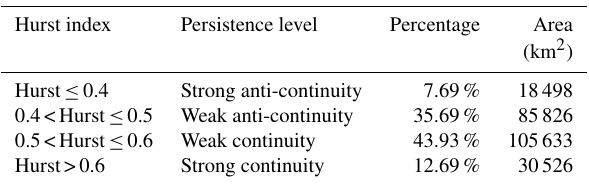
Figure 4. Monthly variation of NDVI in the Yarlung Zangbo River Basin. Table 1. Persistence of monthly NDVI in the Yarlung Zangbo River